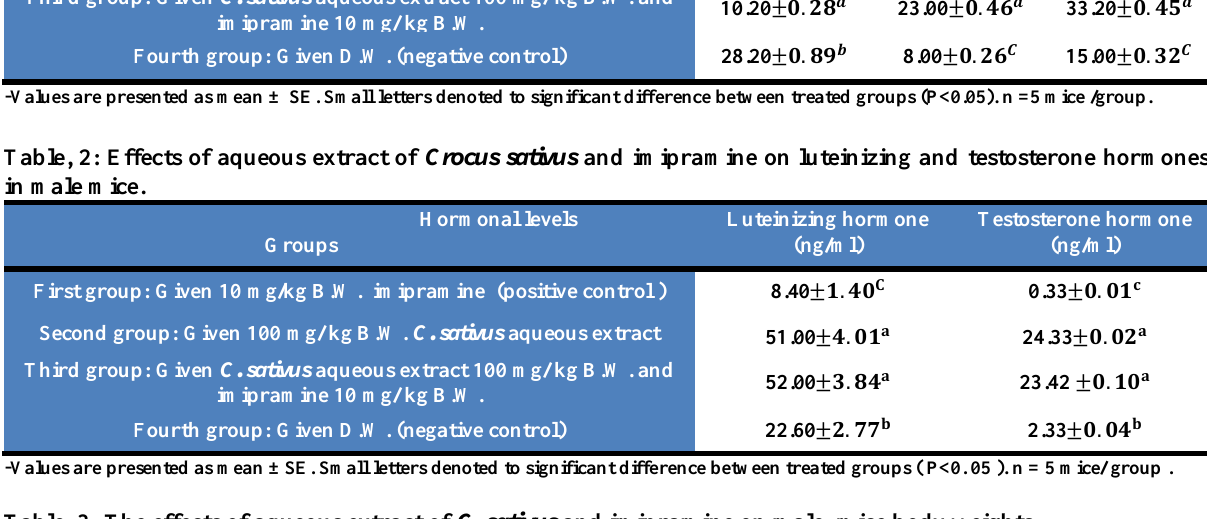
Table, 1: Effects of Crocus sativus aqueous extract and imipramine on male mice sexual activity . Parameters Groups First group: Given 10 mg/kg B.W. imipramine (positive control) 100.00 0.66